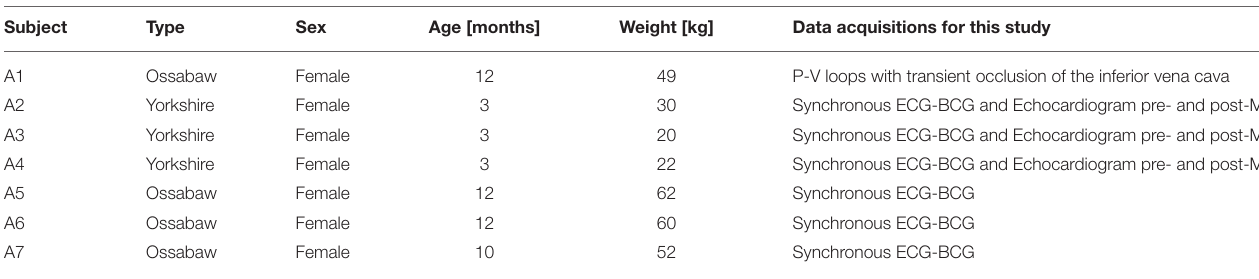
TABLE 1 | Summary of the information on the swine involved in this